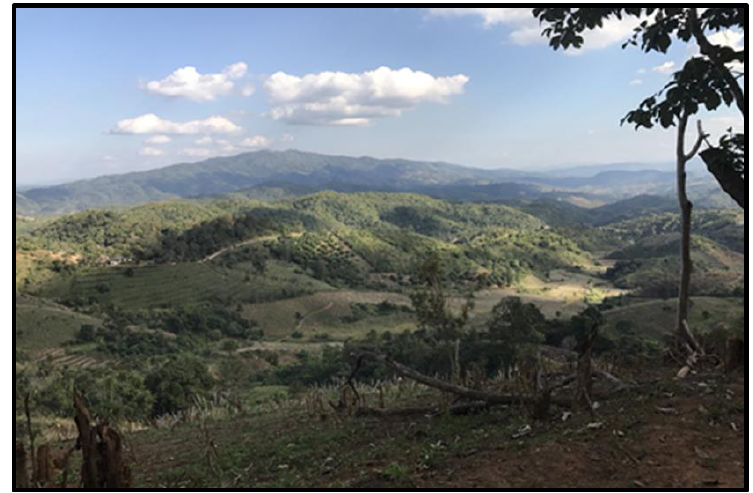
Figure 5. Geographic characteristics of Mae Salong Nai. Source: produced by the authors (2017). Energies 2018 , 11 , x FOR PEER REVIEW